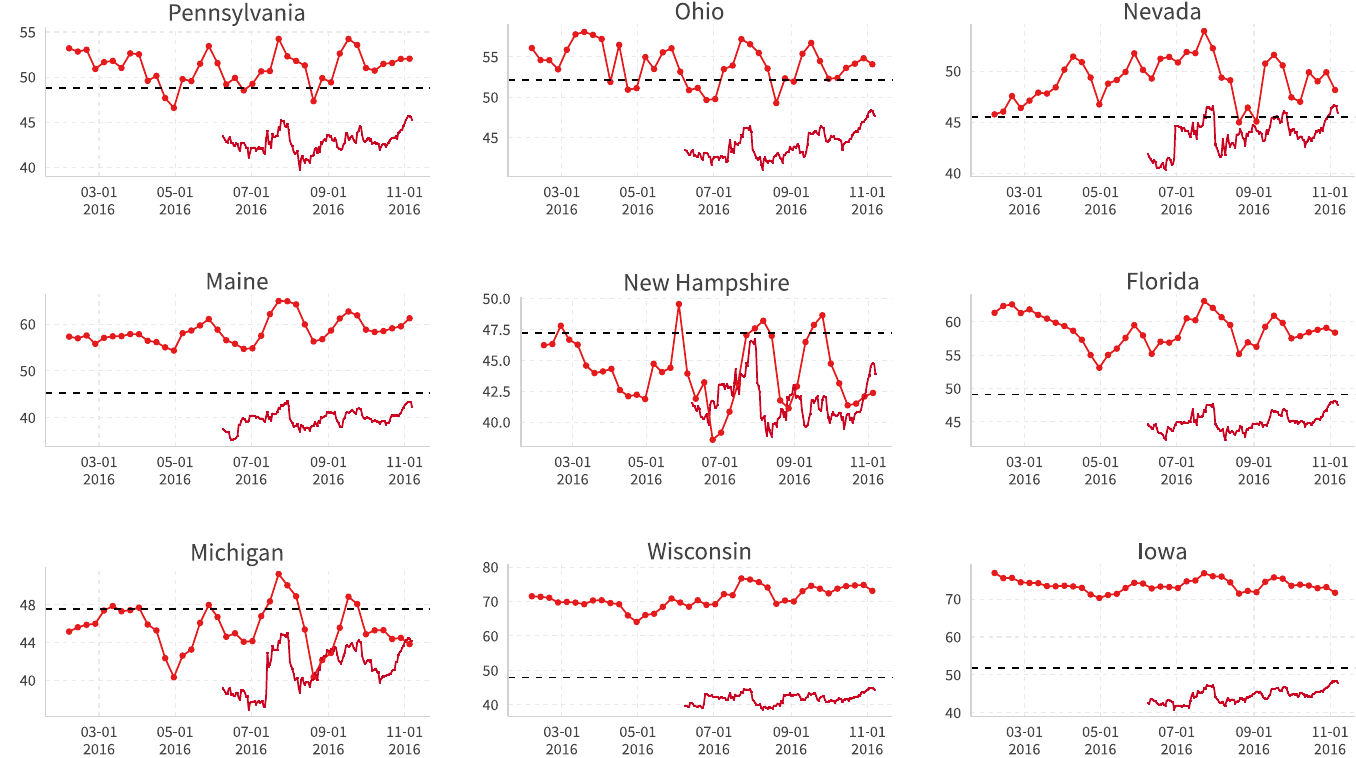
Fig 13. Trump’s Facebook support rate (dotted line), 538 polling average (undotted line), and 2016 actual vote share (dashed line) in selected battleground states. Facebook support rate: Share of user’s ideology closer to Trump. 538 Polling Average: “Nowcast” from [27]. Dickey-Fuller and Phillips-Perron cointegration tests after controlling for candidate-state fixed effects are implemented, where the null hypothesis of no cointegration between these two series is